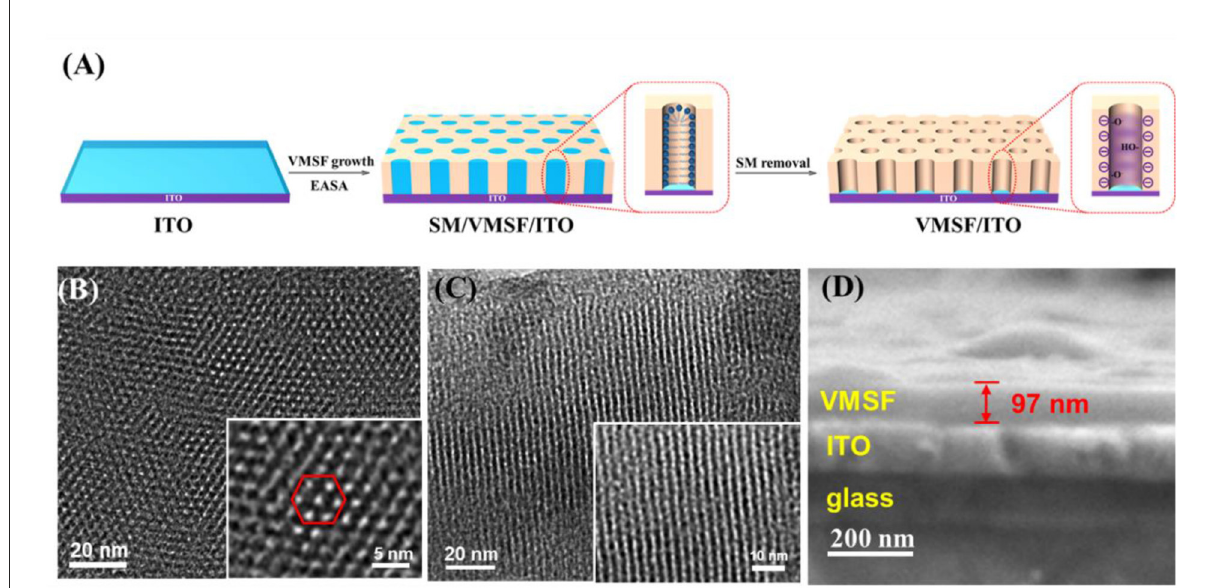
FIGURE1 (A) Schematic illustration for the fabrication of VMSF/ITO electrode. Top-view (B) and cross-sectional (C) images of VMSF. The inset is the corresponding high-resolution TEM image. (D) SEM image of cross-section of